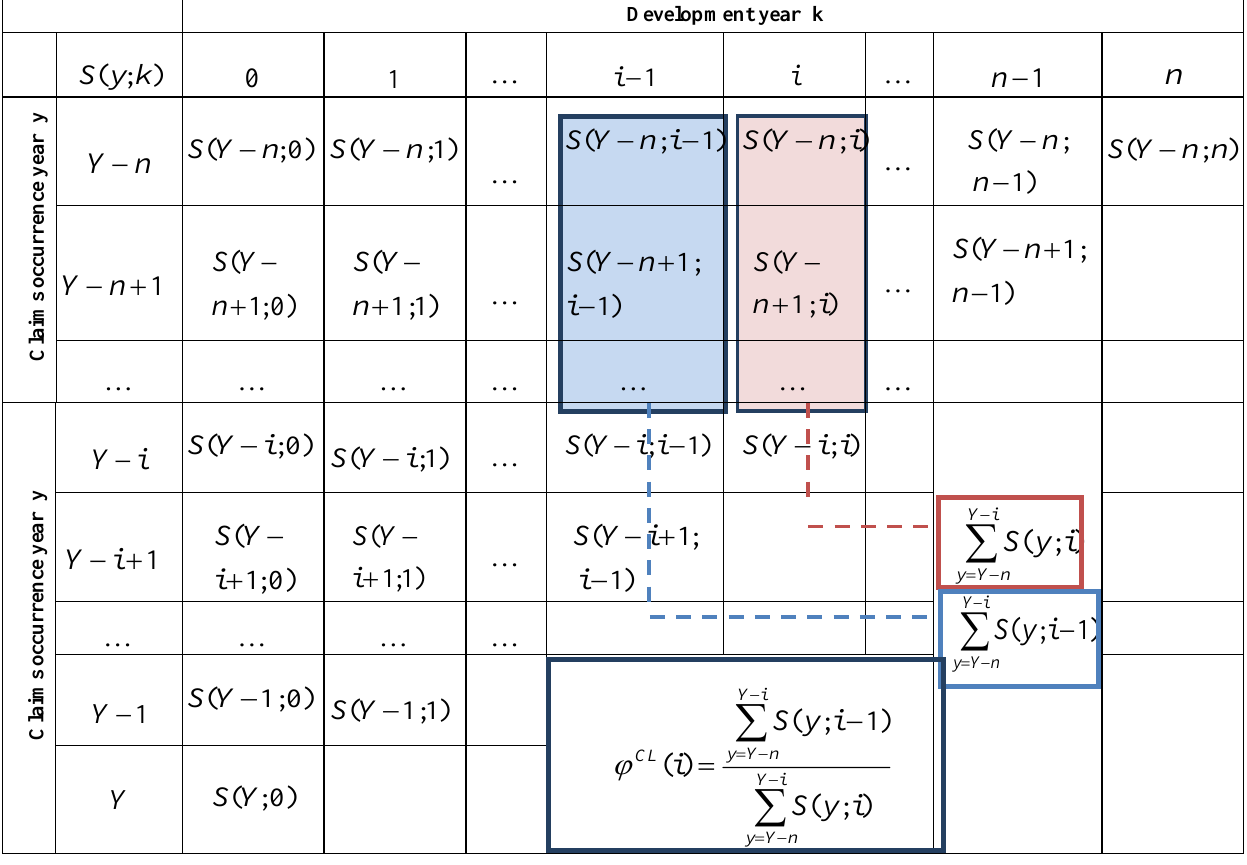
Fig. 3. Determining the CLM estimator for the cumulative claims loss settlement factor, using run-off triangle